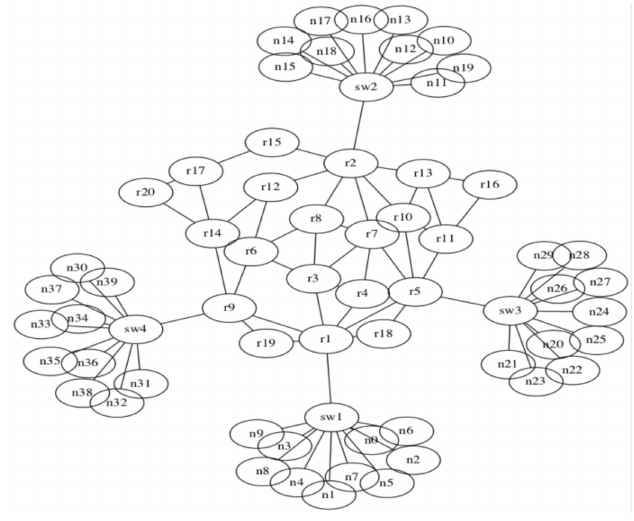
Figure 16. Simulated network topology (number of nodes = 64).